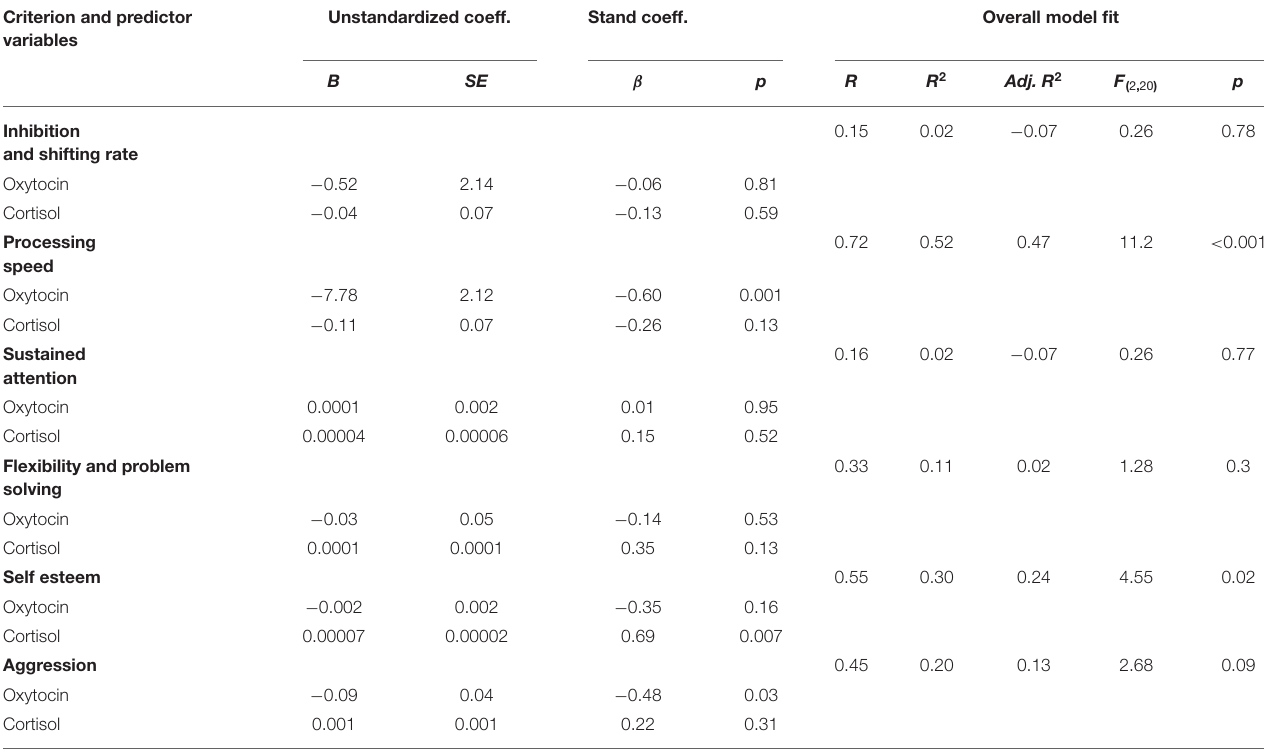
TABLE 3 | Standard multiple regression analyses for predicting response to cognitive and psychological variables from hormonal reactivity. Criterion and predictor Unstandardized variables